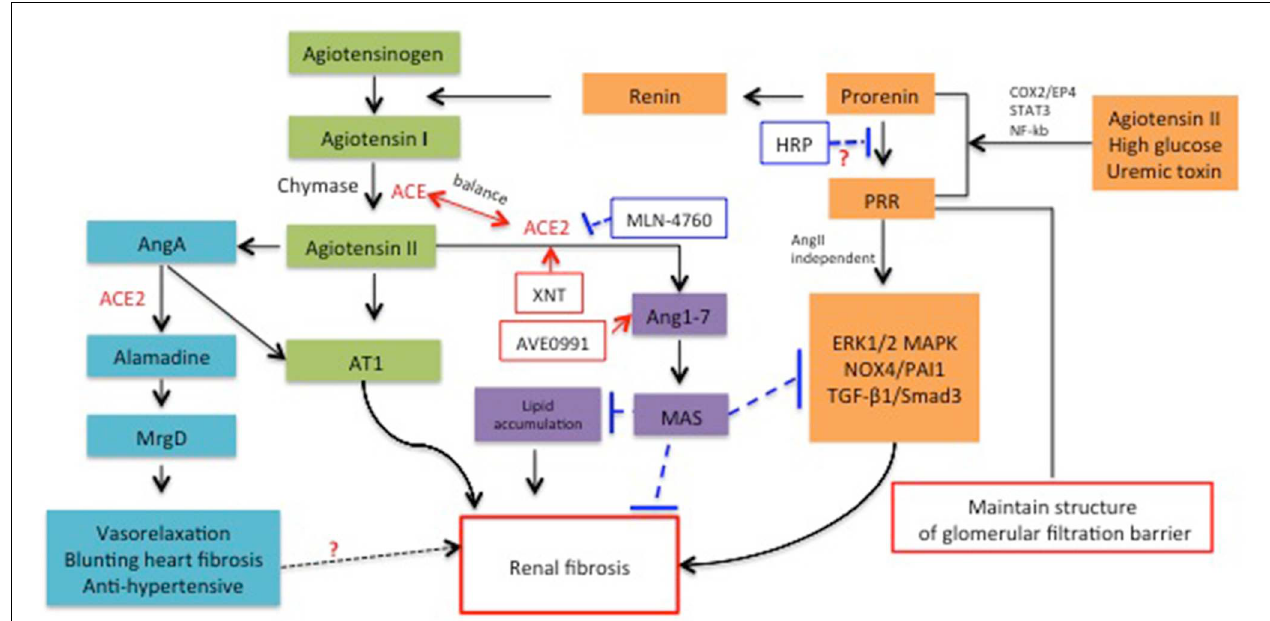
FIGURE 1 | Schematic representation for the role of new members of RAS system in renal fibrosis and the potential molecules targeted RAS for therapeutic application.